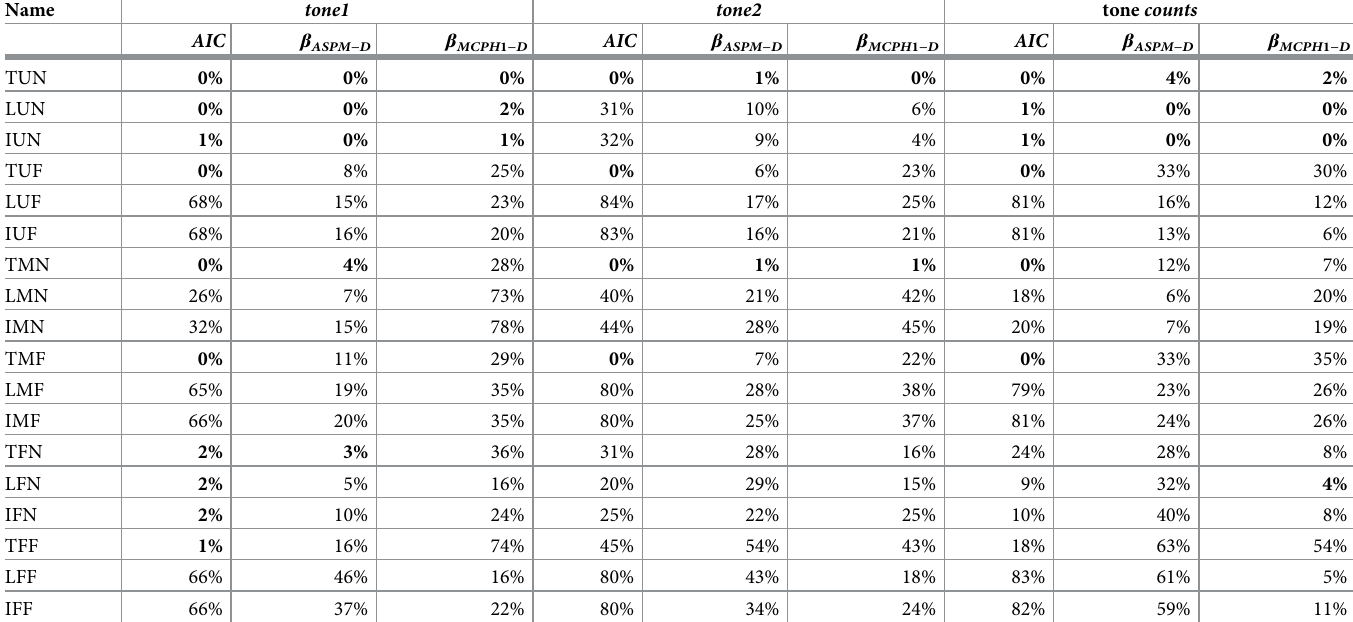
Table 8. The results of the regressions on the randomisation scenarios. The 3-letter scenario name as in 7. For each of tone1 , tone2 and tone counts , I show the percent of models fitted on permuted data that, compared to the model fitted on the original data, have a better AIC, a smaller (i.e., more negative) regression coefficient β for ASPM -D, and a smaller β for MCPH1 -D, respectively. The lower these percentages, the more “special” is the relationship on the original dataset relative to the structure that is destroyed in each scenario. In bold are the values < 5%.